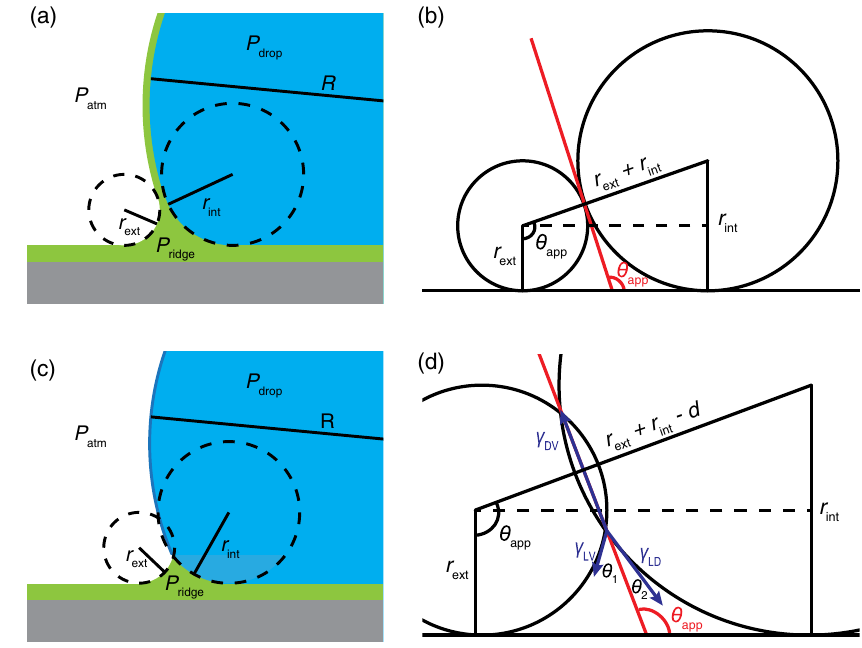
> 0 ). (b) Geometric construction used LD < 0 ). (d) Geometric construction used to LD